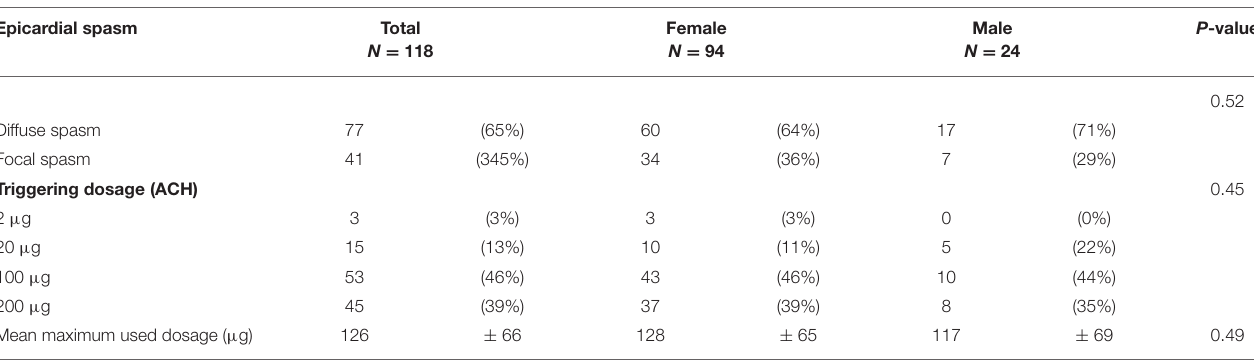
TABLE 3 | Epicardial spasm characteristics according to